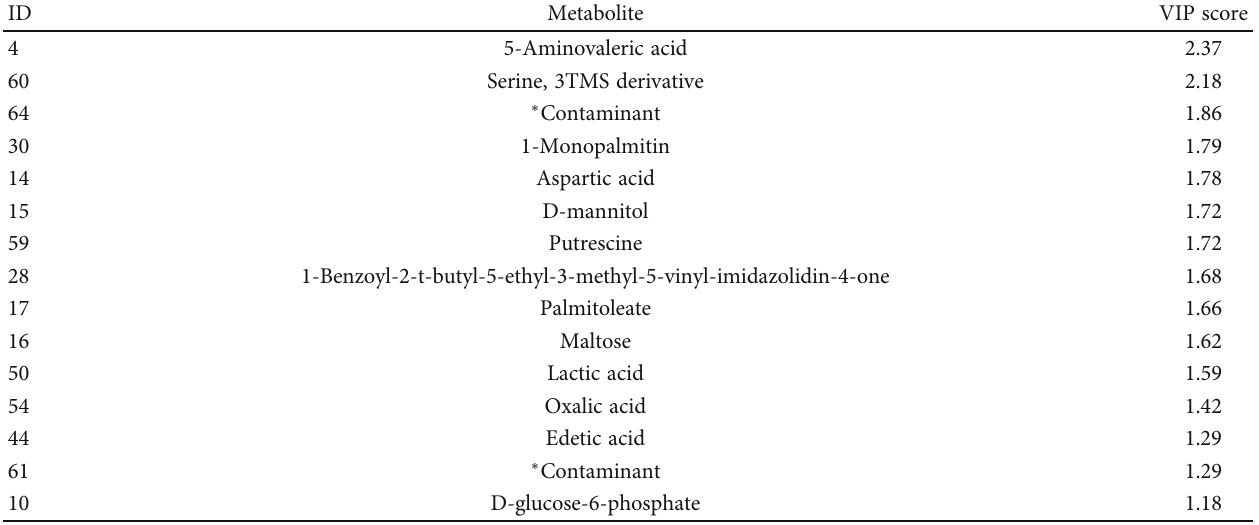
Table 3: Metabolites important for group separation according to partial least squares-discriminant analysis (PLS-DA) and their variable importance in projection (VIP)